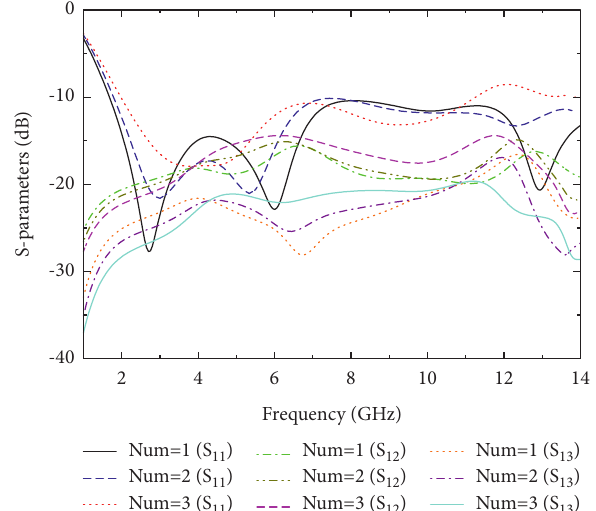
Figure 13: S -parameter simulation results of different numbers of X-shaped stubs of four-port antenna.